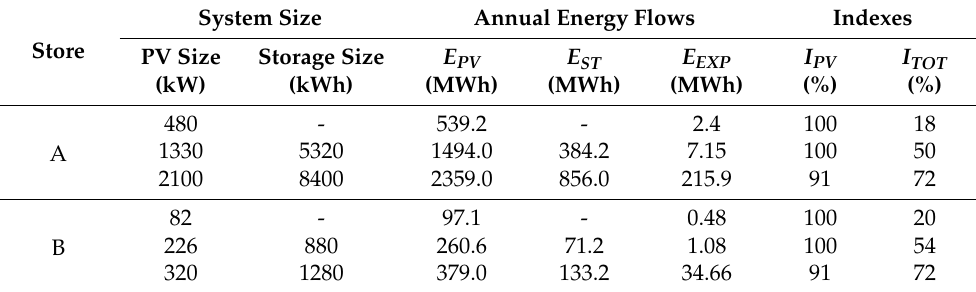
Table 7. PV production data for full self-consumption based on hourly data analysis (with storage system). System Store